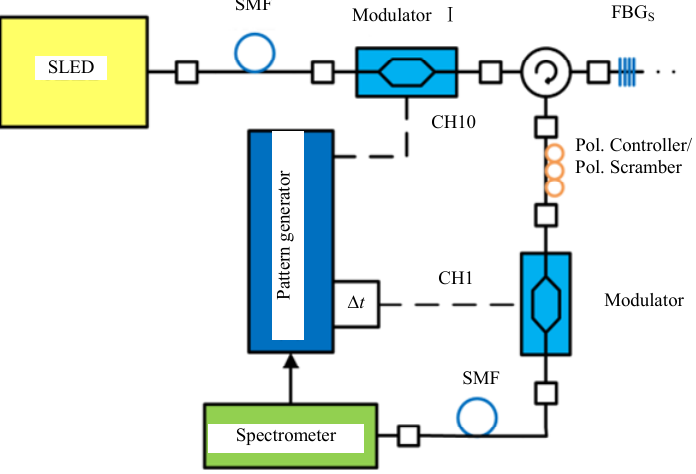
Fig. 7 CDM-WDM interrogator system